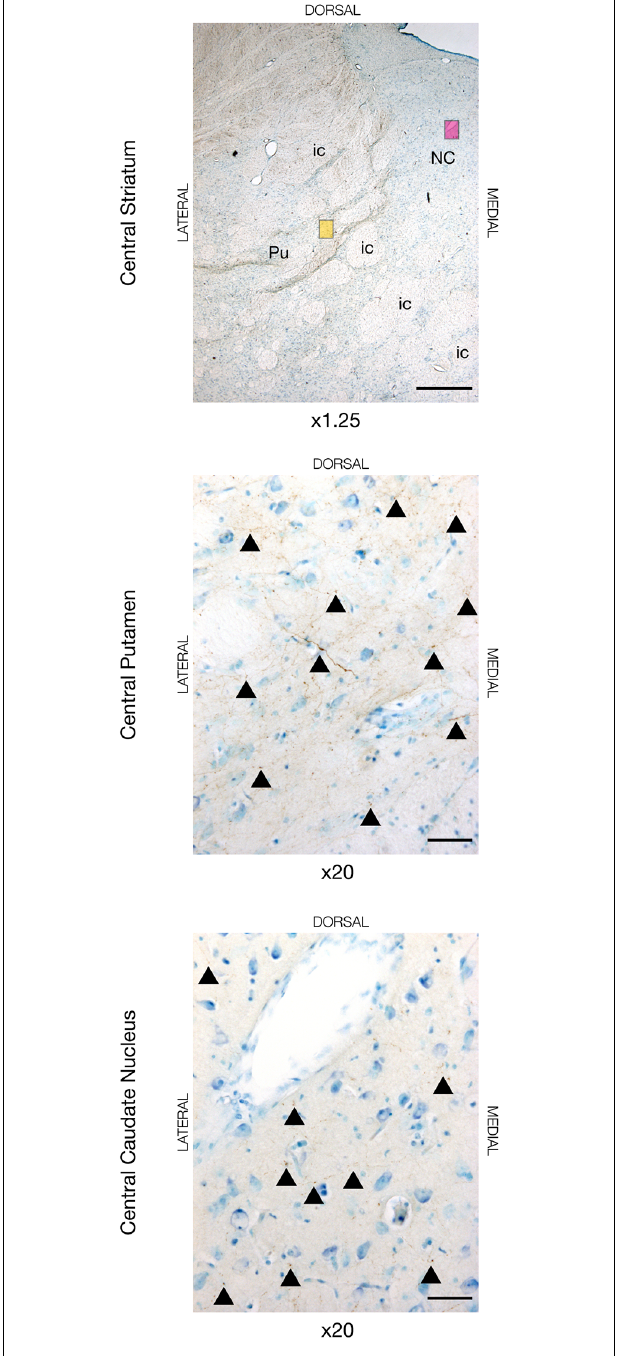
FIGURE 1 | Neuronal tracing with Biotinylated Dextran Amine (BDA) in the dorsal striatum in JBG-3. The upper image is for overview displaying the central segment of the striatum with the putamen (Pu), caudate nucleus (NC), and intersecting internal capsule (ic). The yellow miniature window is showing the area in the dorsal putamen seen in x20 magnification on the middle image. The magenta miniature window is showing the area in the dorsal caudate nucleus seen in x20 magnification on the bottom image. Note the golden-brown traced fibers revealing numerous axons and terminations marked with arrowheads. Counterstaining with toluidine blue. Scale bars = 1 mm (x1.25) and 50 µ m